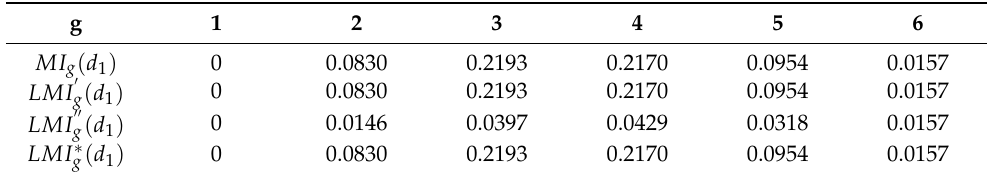
Table 1. Numerical results of designs d 1